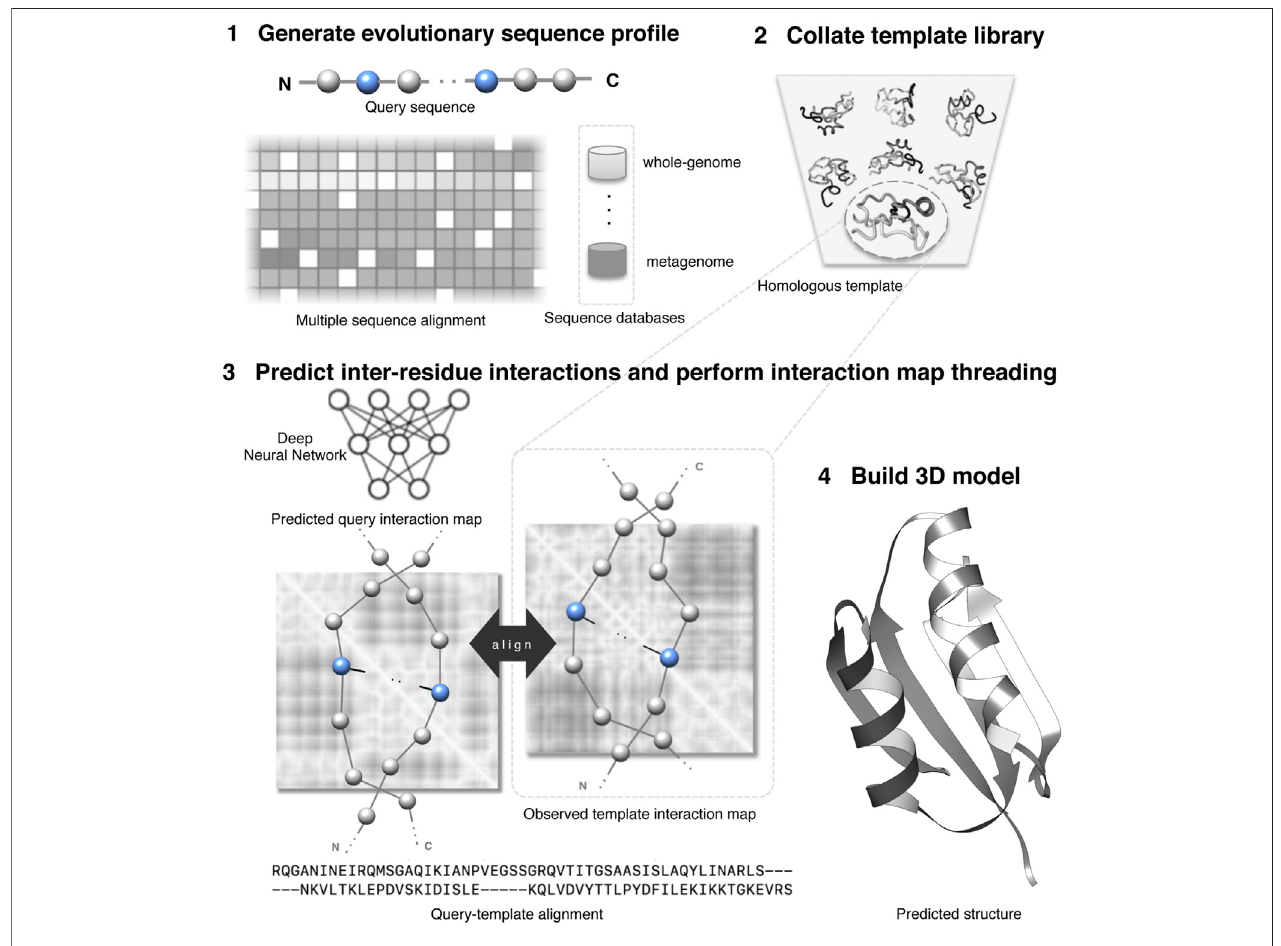
FIGURE 1 | Illustration of protein interaction map